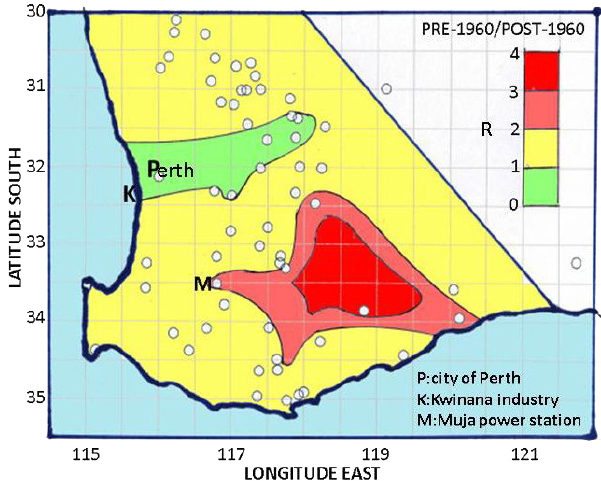
Figure 7. Contours of R (ratio of pre-1960 to post-1960 CD FH ) for the sites in Table